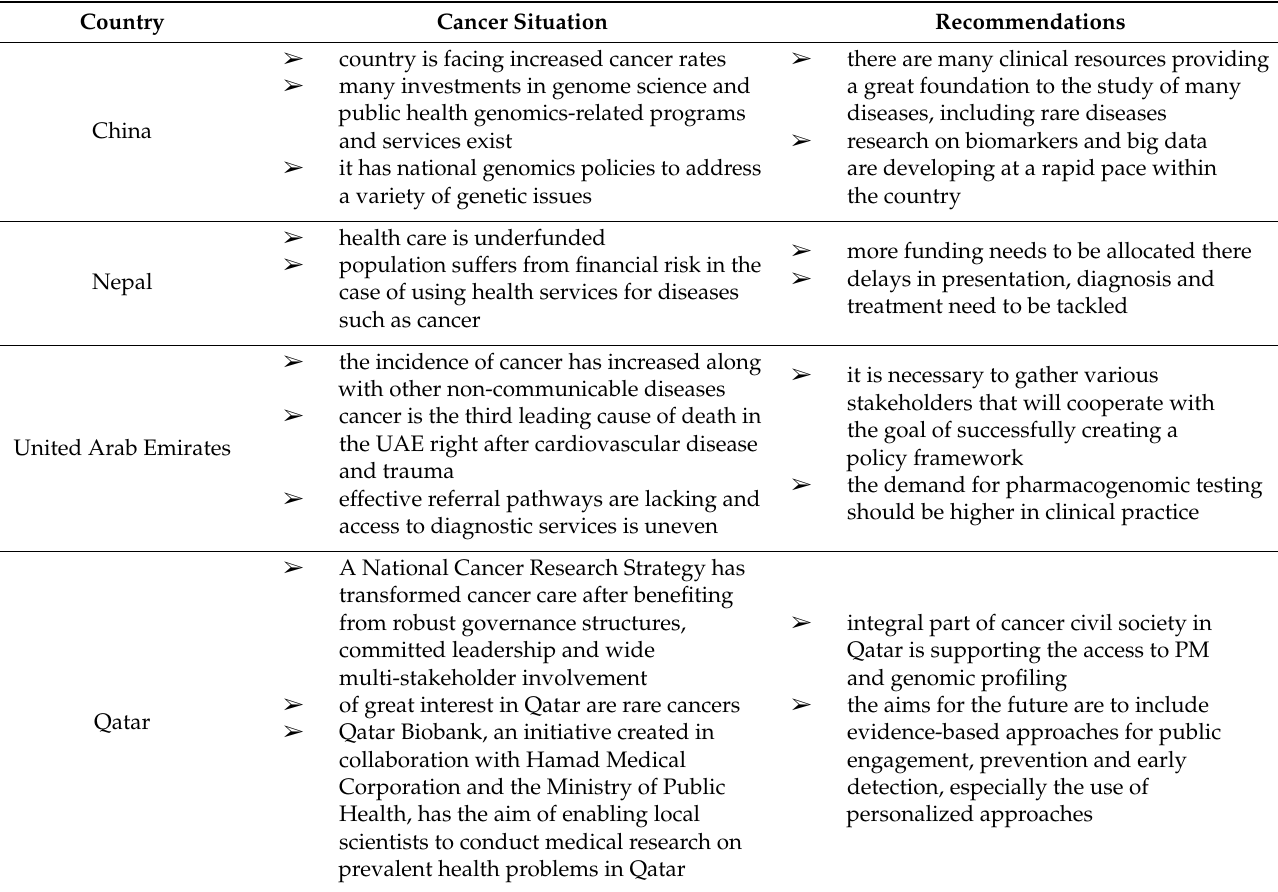
Table 2. Cancer situation and related recommendations in different Asian countries. Country Cancer